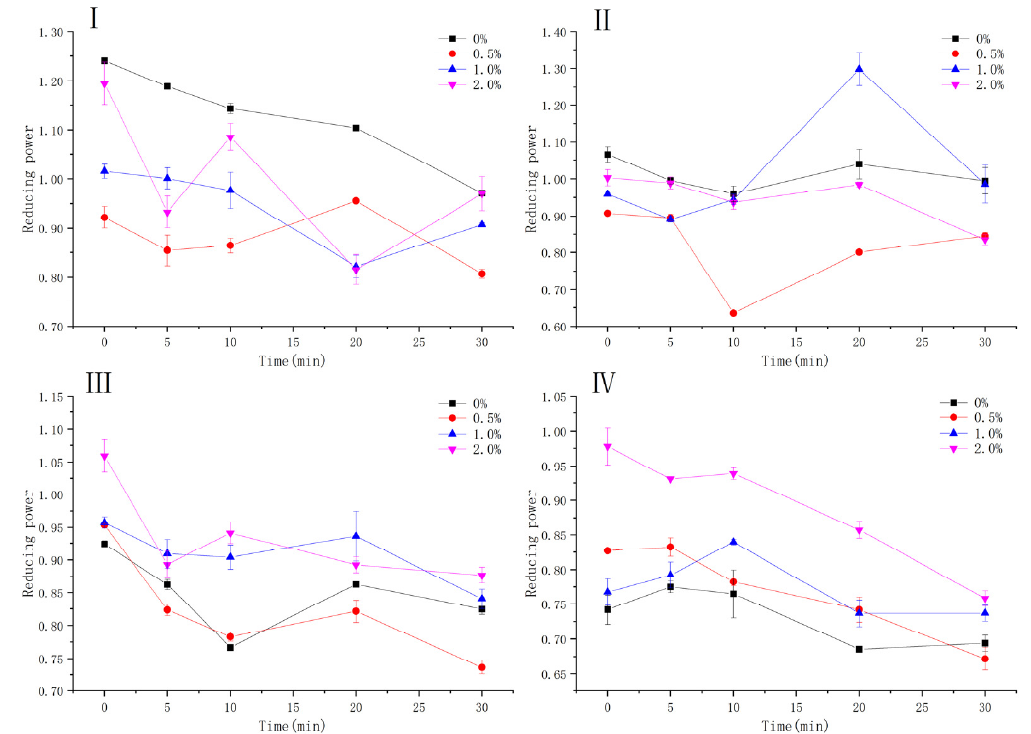
Figure 13. The reducing power of enzymatic browning products of ( I ) Catechin ( II ) Epicatechin ( III ) Caffeic acid ( IV ) Chlorogenic acid under the effect of different concentrations of eugenol. The reducing power of the control group of CGA was 0.74 compared to 0.84 and 0.77 of 0.5% eugenol and 1.0% eugenol at 0 min. The value of CT with 2% eugenol was 0.98. For CA and CGA, eugenol increased the reducing power of enzymatic products. Moreo- ver, the higher the concentration, the greater the increase. Eugenol could scavenge radi- cals [38]. Therefore, a large amount of eugenol raised the reducing power of the products of CA and CGA. 3.5. Computational Docking Simulation of Polyphenols Binding to Tyrosinase The docking conformations of the tyrosinase and four compounds (CT, EC, CA, and CGA) are shown in Figure 14. The CT, EC, CA, and CGA were docked into the key active sites of the tyrosinase, respectively.